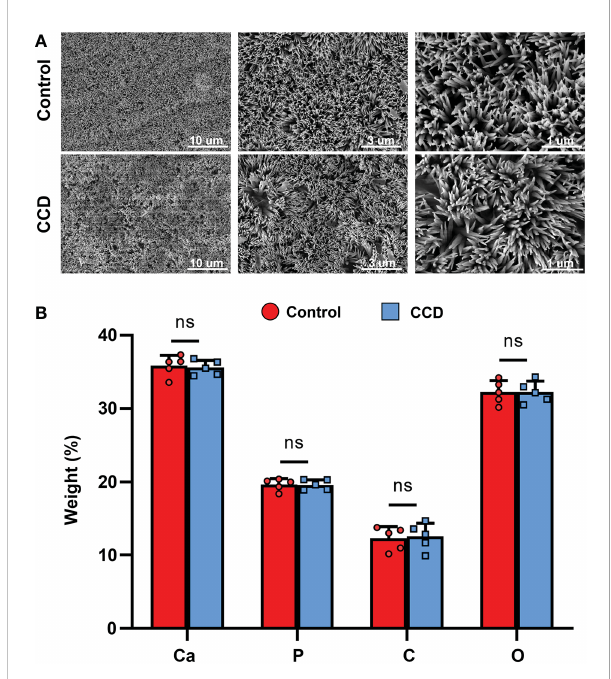
FIGURE 8 Lyso-PEG as a matrix for dentin remineralization of patients with CCD. (A) SEM images of Lyso-PEG-induced remineralization structures on dentin of the two groups. Scale bars: 10, 5, and 1 m m. (B) Weight percentage of the elements of tooth slabs in two groups (n = 5, ns p >